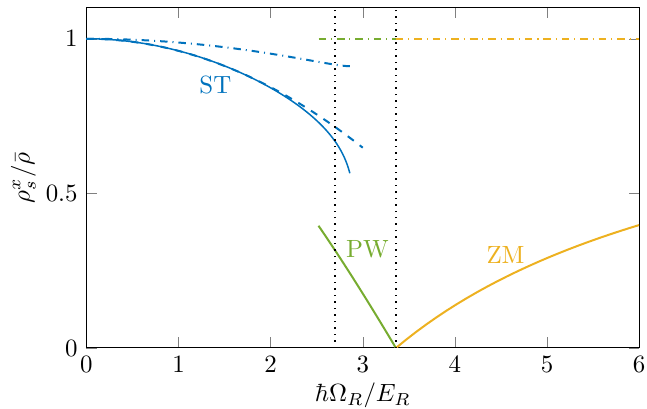
Figure 4: Superfluid density estimated from Eq. (60) as a function of the Raman coupling Ω . The solid blue, green, and yellow lines show the exact values in the R stripe (ST), plane-wave (PW), and zero-momentum (ZM) phase, respectively; the blue dashed line corresponds to the perturbation results in the stripe phase up to / 4 E second order in ħ h Ω . For each phase we also report the estimates obtained R R from the Leggett criterion (61) (dash-dot curves). The vertical black dotted lines = 2.70 E = 3.36 E at ħ h Ω and ħ h Ω identify the transitions between the various R R R R phases. Besides the spinodal behavior of the stripe phase we previously pointed out, here we see that the plane-wave phase can be found as a metastable state down = 2.52 E to ħ h Ω , where the roton gap in its excitation spectrum vanishes (see R R Ref. [ 49 ] ). The interaction parameters are the same as Fig.